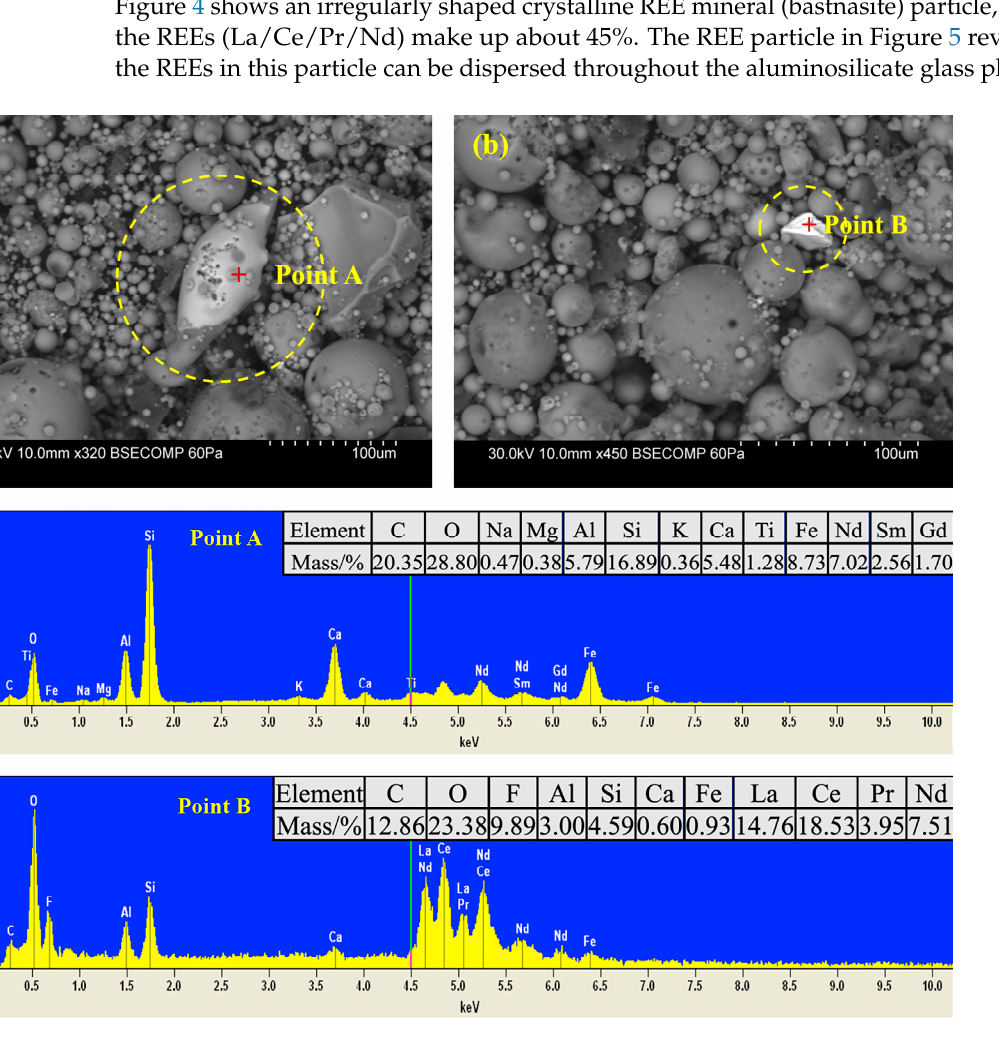
Figure 5. EPMA-WDS quantitative elemental mapping of the coal fly ash sample. The scale bar is 4 µm. Analysis conditions: 20 kV, 45 nA, and a map dwell time of 250 ms.